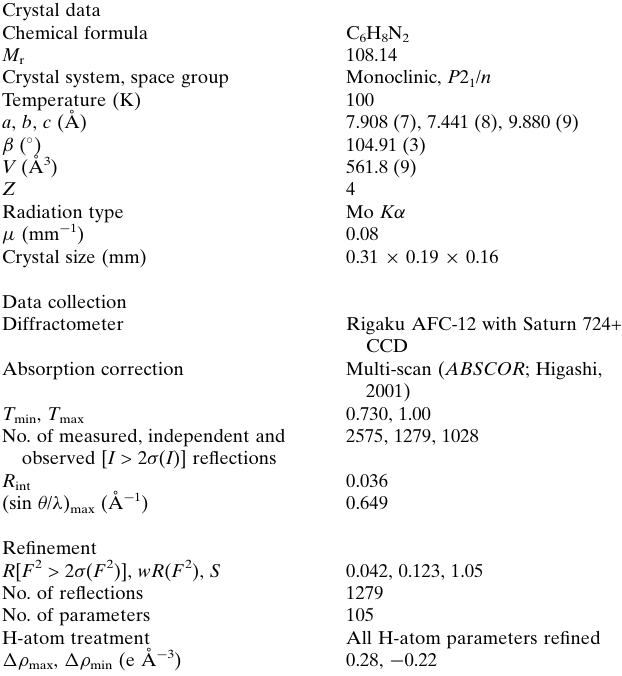
Table 2 Experimental details. Crystal data Chemical